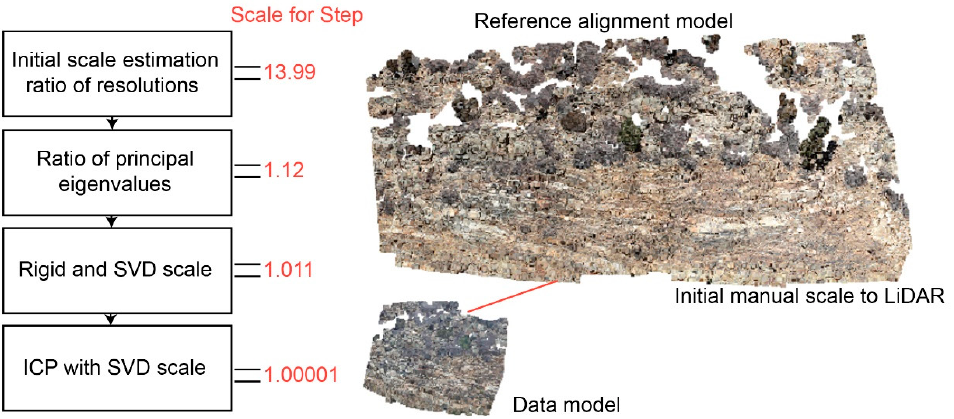
Figure 6. Registration pipeline for change analysis without ground control.